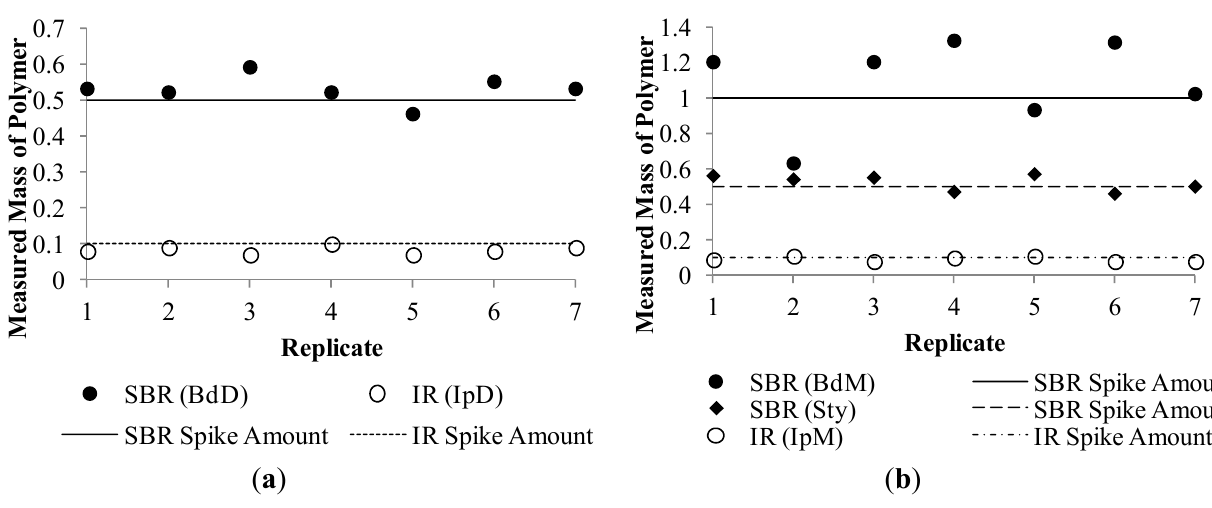
Figure 3. Measured polymer concentration in detection limit study for seven replicates. ( a ) Dimer markers butadiene (BdD) and isoprene (Ipd). ( b ) Monomer markers butadiene (BdM), Isoprene (IpM) and Styrene (Sty).